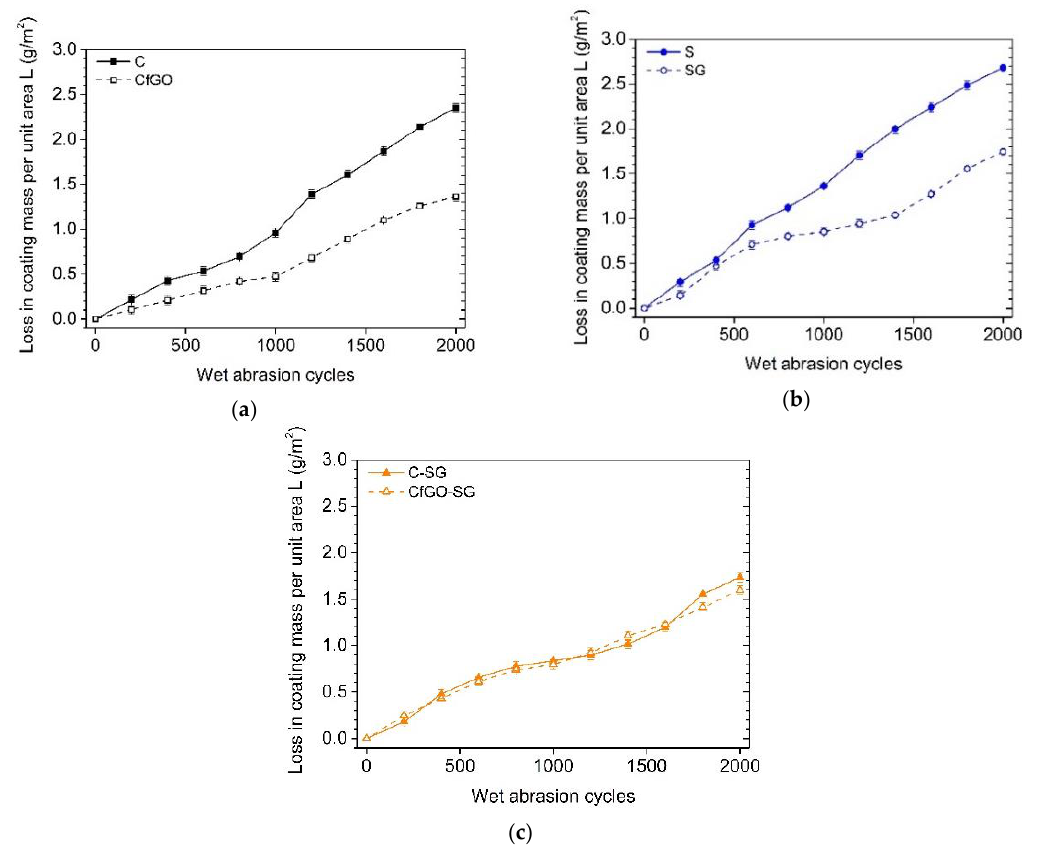
Figure 14. Loss in coatings mass per unit area, as a function of the abrasion cycles number, for ( a ) cataphoretic layers, ( b ) spray coatings and ( c ) double layer samples.